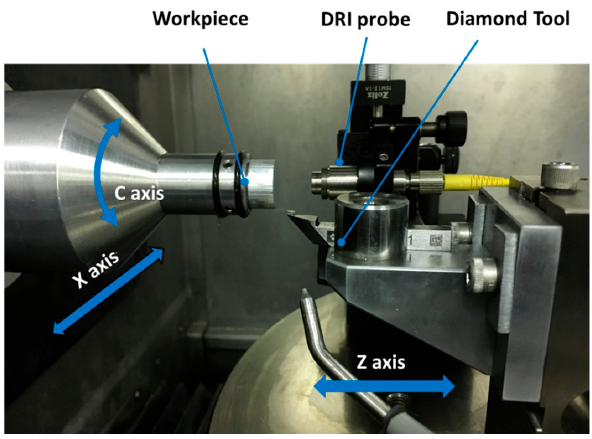
Figure 1. On-machine surface measurement system configuration.